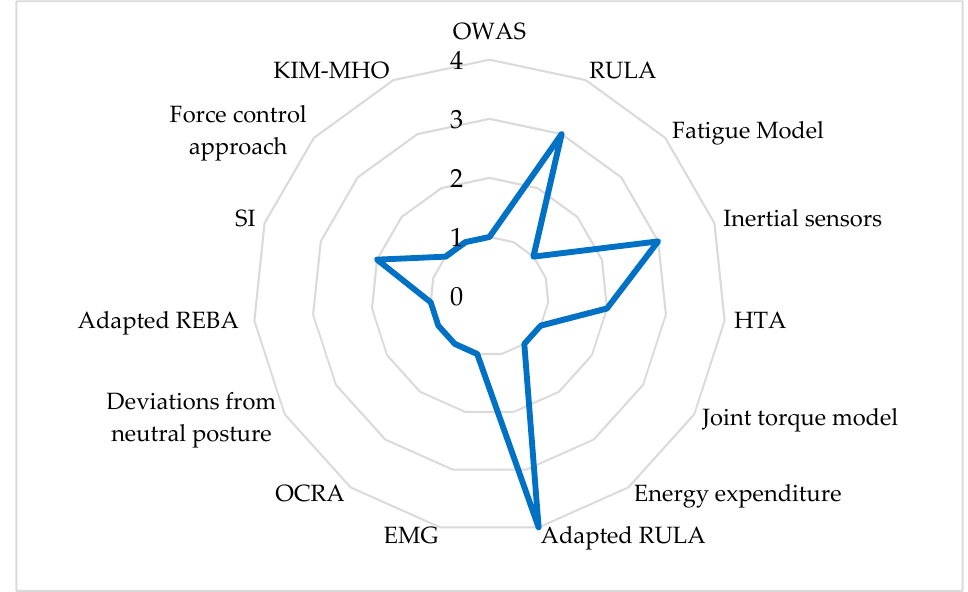
Figure 6. Distribution of physical ergonomics assessment methods used in the reviewed studies. Additionally, some reviewed studies applied direct measurement ergonomic